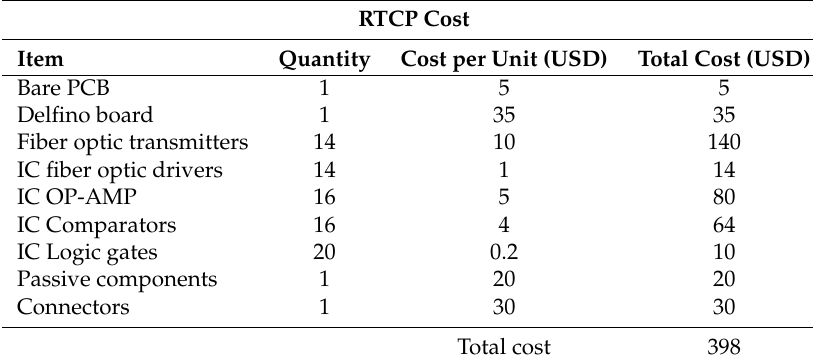
Table 2. Main components and cost of the RTCP.